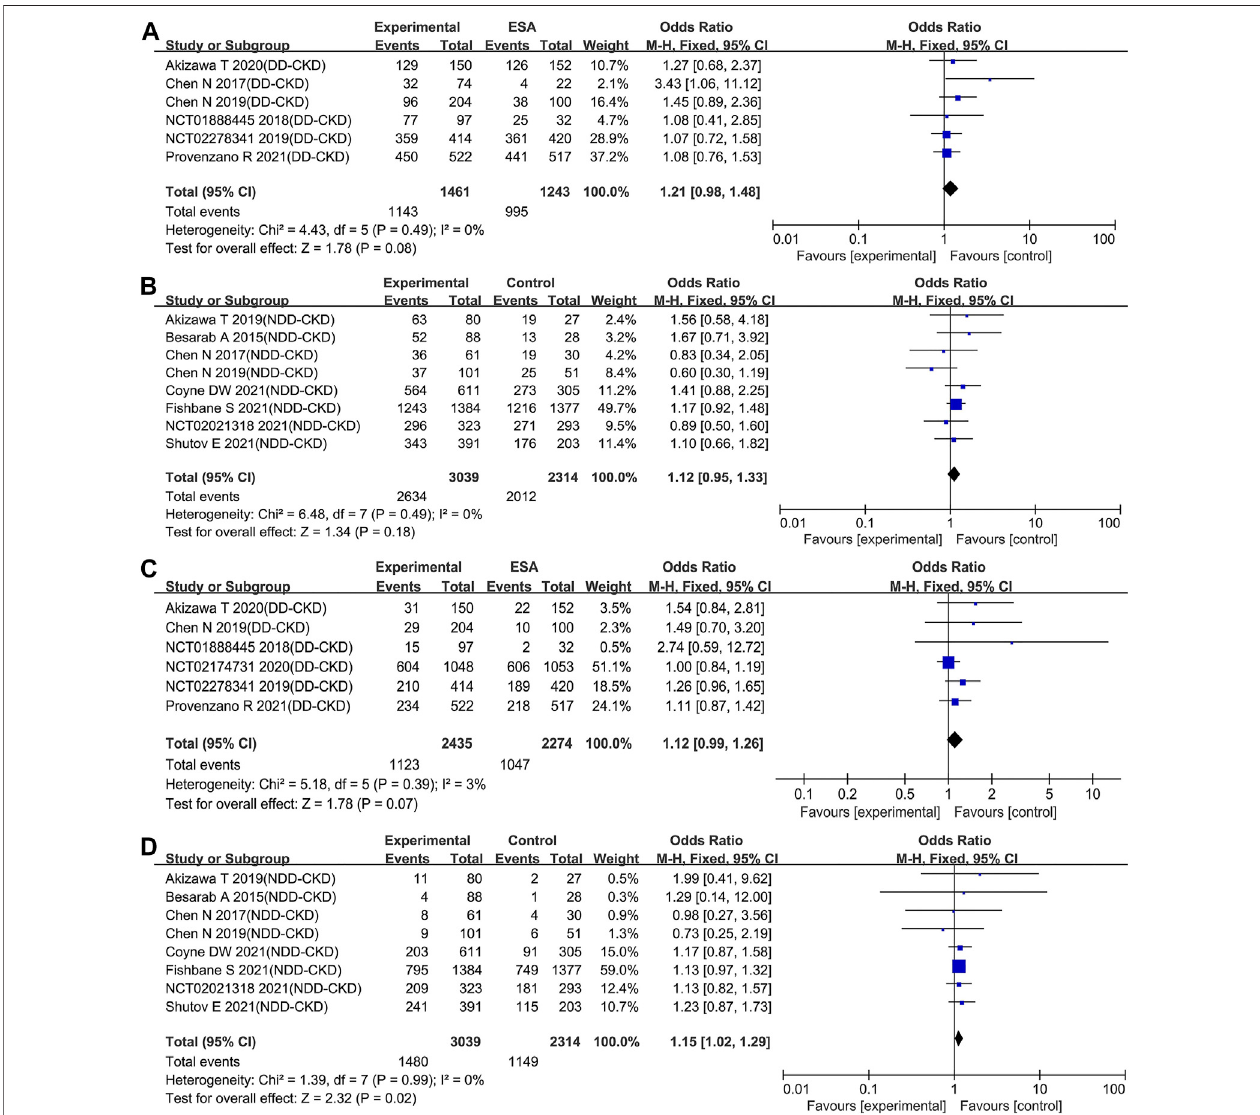
FIGURE 6 | Effect of roxadustat compared with ESA or placebo on the incidence of TEAEs (A, B) and serious TEAEs (C, D) in CKD patients. Notes: CKD, chronic kidney disease; DD-CKD, dialysis-dependent chronic kidney disease; NDD-CKD, non-dialysis-dependentchronic kidney disease; TEAEs, treatment-emergent adverse